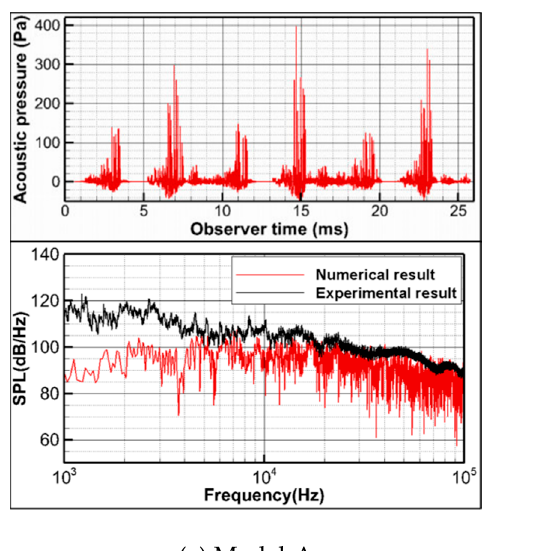
Figure 22. Predicted acoustic pressure due to tip vortex cavitation in the time and frequency domain for ( a ) Model-A and ( b ) Model-B.